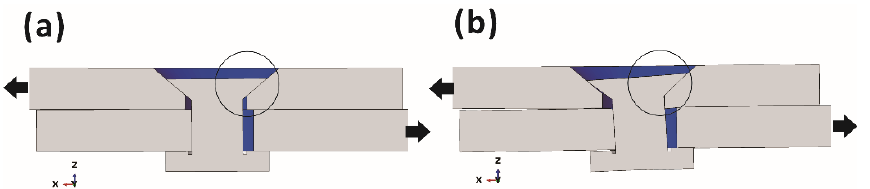
Figure 11. The contact behavior of a defective joint ( a ) before the transition point and ( b ) after the transition point.